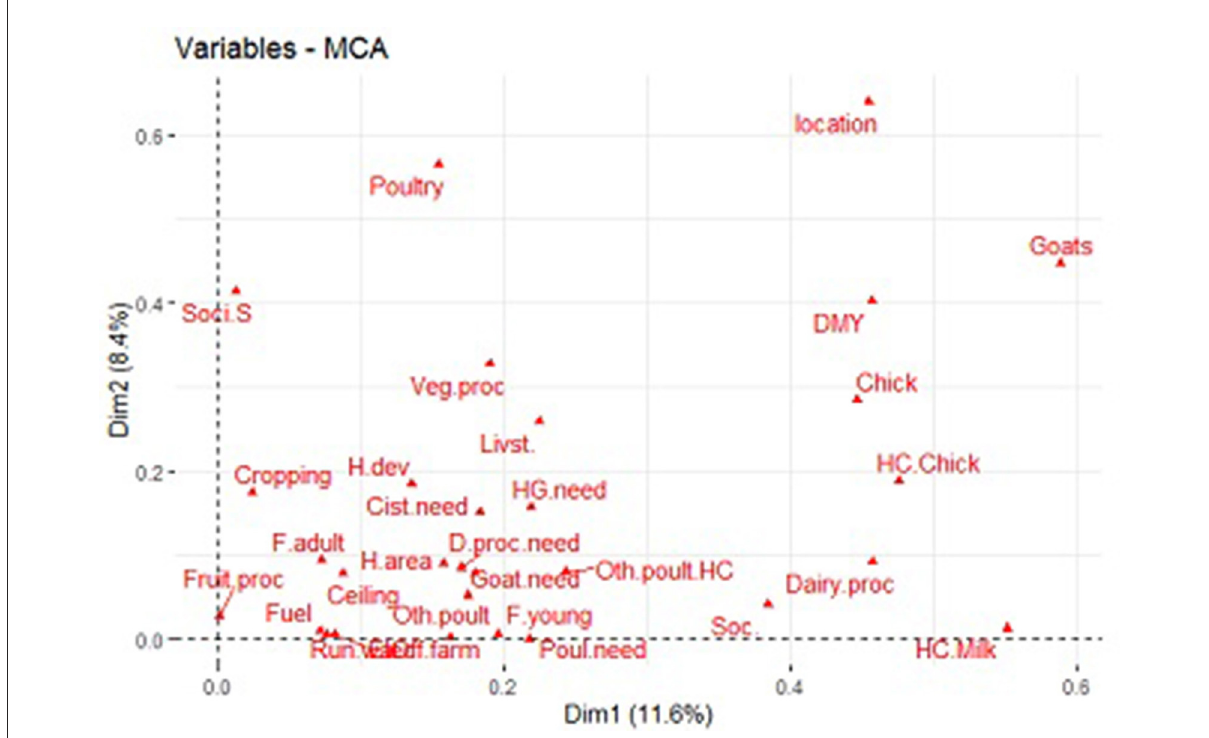
FIGURE8 Mapping of the main variables for the women.